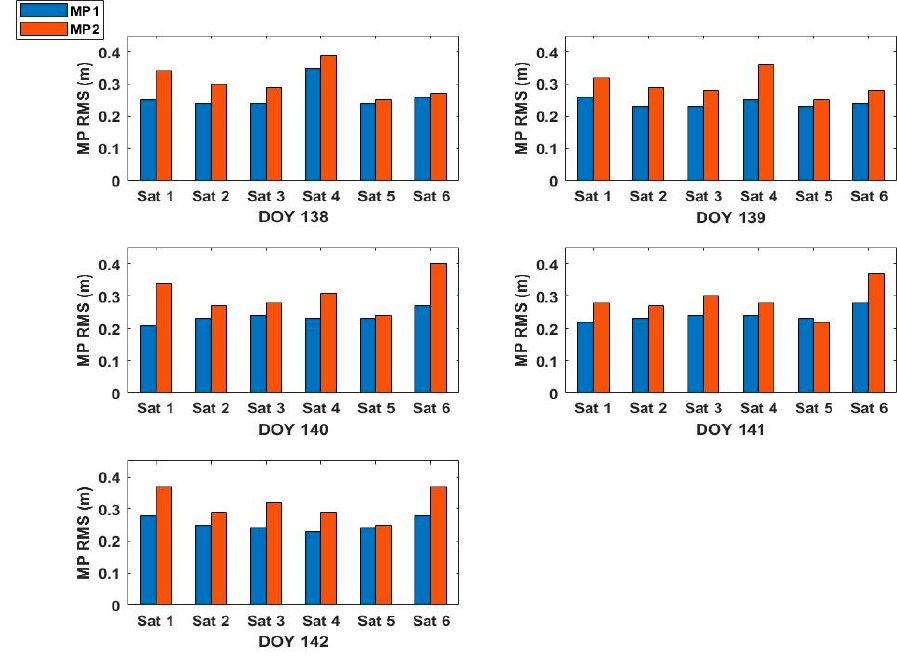
Figure 5. Multipath errors of each COSMIC-2 satellite during DOY 138–142, 2021.